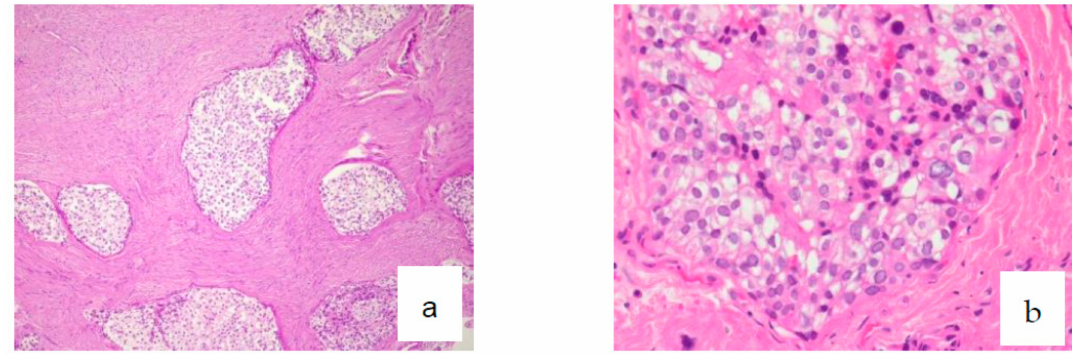
Figure 3. ( a ) PAS positivity for glycogen ( × 10), ( b ) nuclear atypias (Ki67 < 1%) ( × 20).